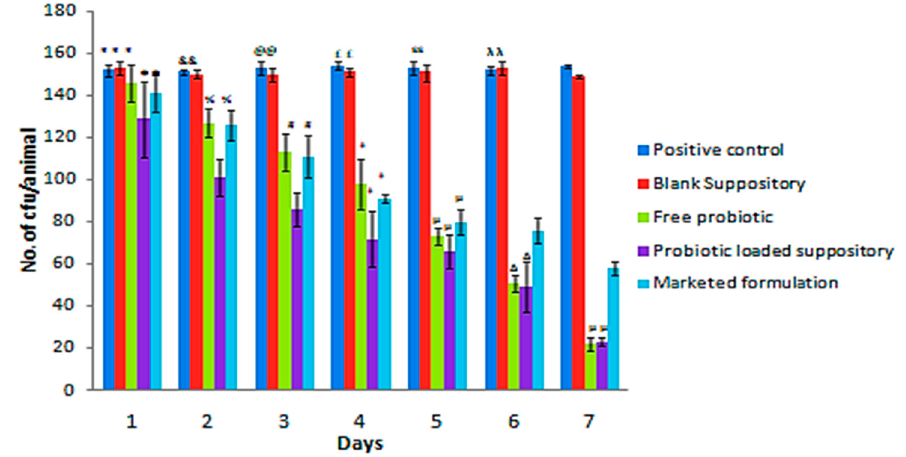
Figure 12. Effect of various treatments every day for seven days on the reduction in cfu of Candida in the rat model of vulvovaginal candidiasis ( n = 3). All groups differ significantly except those marked similarly (intraday comparison between different groups) at p < 0.001.